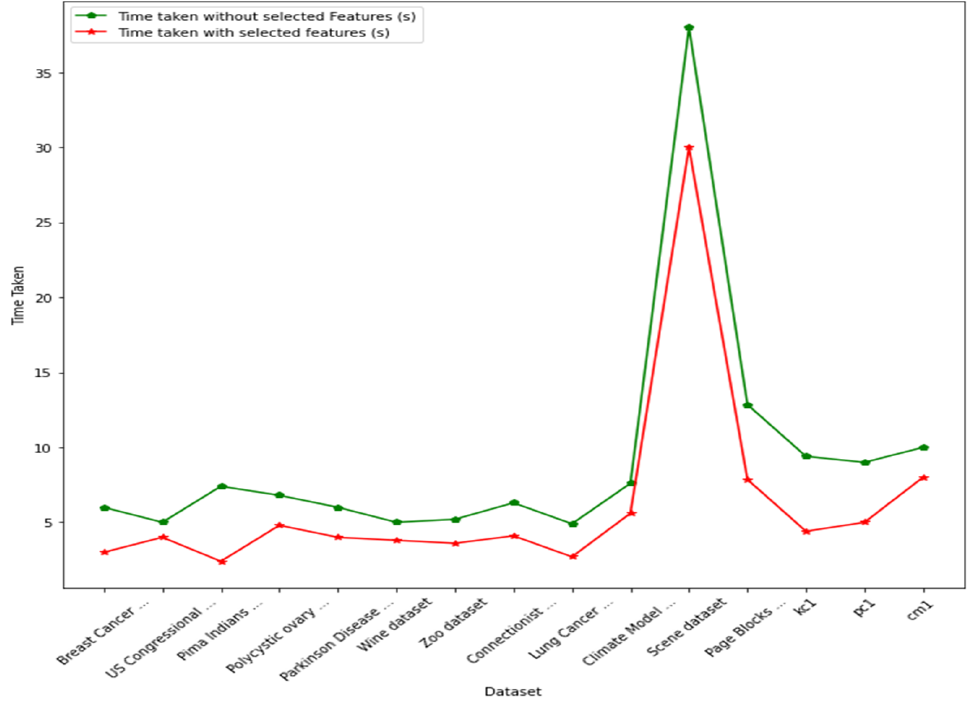
Figure 7. Comparison of time taken for classification with and without feature selection.